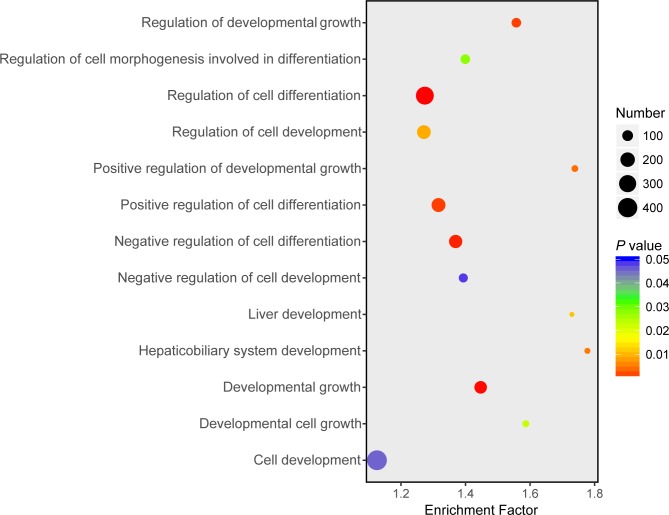
Cell differentiation and liver development related GO categories enriched for genes modified by m6A methylation.Some genes consistently modified by m6A methylation in all three stages were specifically involved in cell differentiation- and liver development- related categories. Different colors represent P values, and sizes represent gene numbers. X-axis represents fold enrichment. Detailed functional enrichment analysis results of all consistently modified genes, are available in S6 Table.